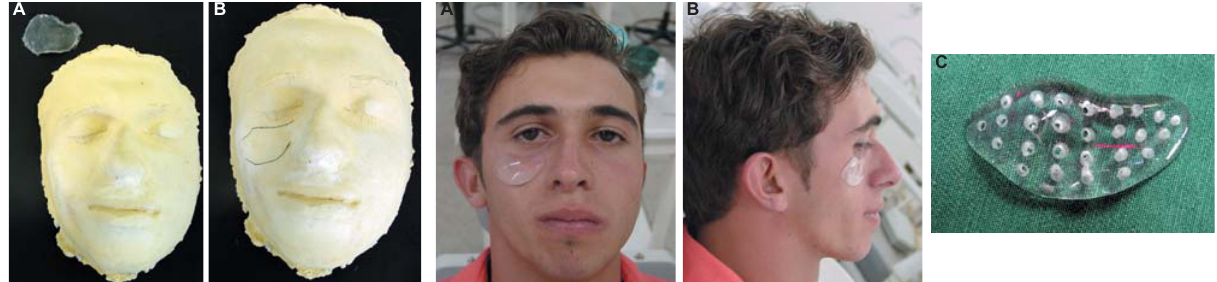
Figure 3A-C- The facial prosthesis was sculpted. The appropriate shape was obtained (patient signed informed consent authorizing the publication of these